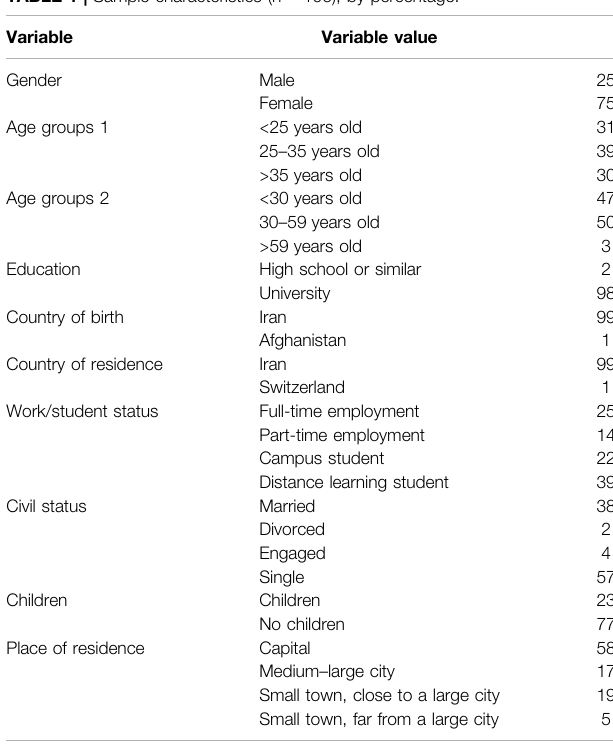
TABLE 1 | Sample characteristics (n (cid:1) 196), by